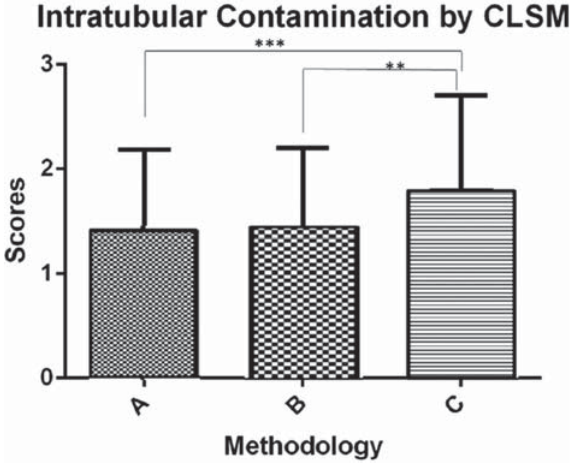
Figure 4- (cid:3) (cid:38)(cid:79)(cid:68)(cid:86)(cid:86)(cid:76)(cid:191)(cid:70)(cid:68)(cid:87)(cid:76)(cid:82)(cid:81)(cid:3) (cid:82)(cid:73)(cid:3) (cid:86)(cid:70)(cid:82)(cid:85)(cid:72)(cid:86)(cid:3) (cid:82)(cid:73)(cid:3) (cid:76)(cid:81)(cid:87)(cid:85)(cid:68)(cid:87)(cid:88)(cid:69)(cid:88)(cid:79)(cid:68)(cid:85)(cid:3) contamination observed in the confocal laser scanning microscopy (CLSM) images, performed by three examiners (A×C, p=0.015) (B×C, p=0.022). The symbol ** shows the statistical difference between groups B and C (p<0.05), and the symbol *** shows the statistical difference between groups A and C (p<0.01)